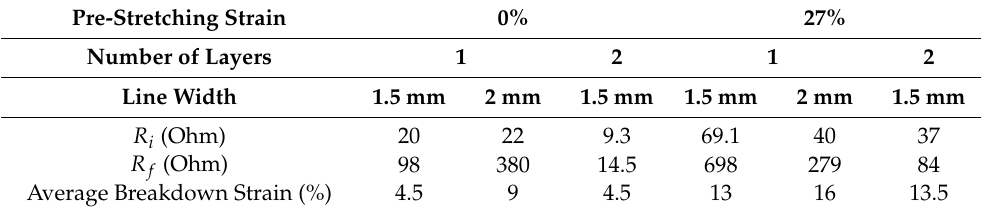
Table 1. Initial and final resistances and average breakdown strain of horseshoe patterns with and without radial pre-stretching.